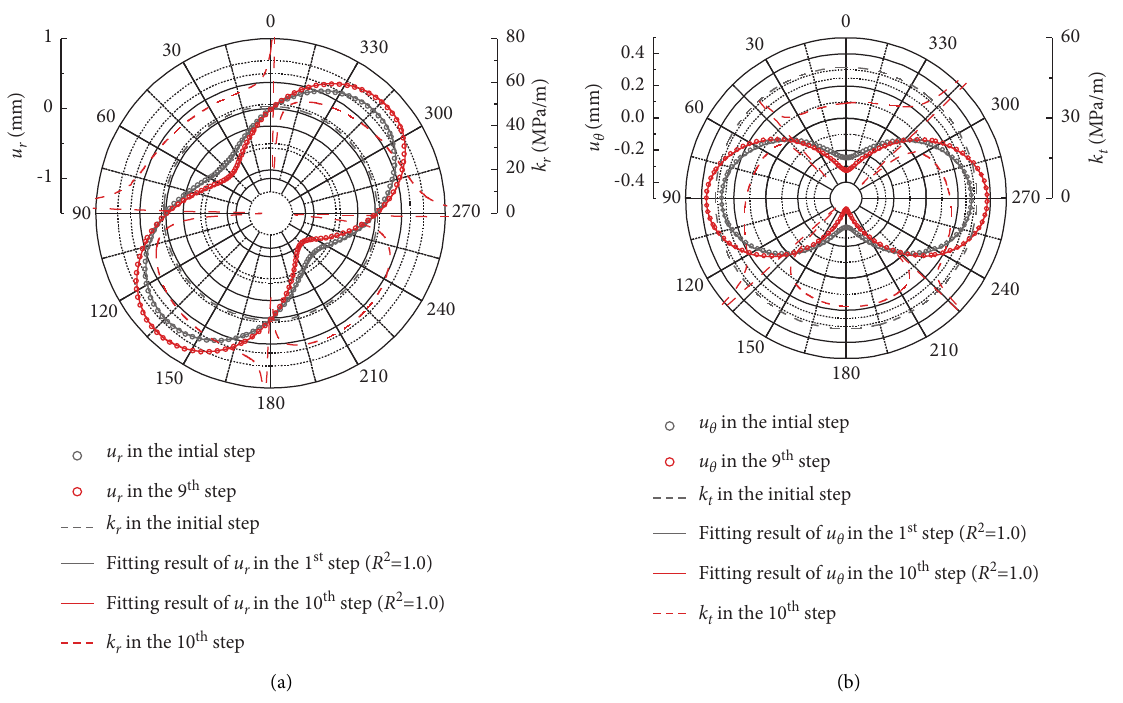
Figure 9: Displacement fitting result in the first and tenth steps. (a) Radial displacement; (b) tangential displacement.